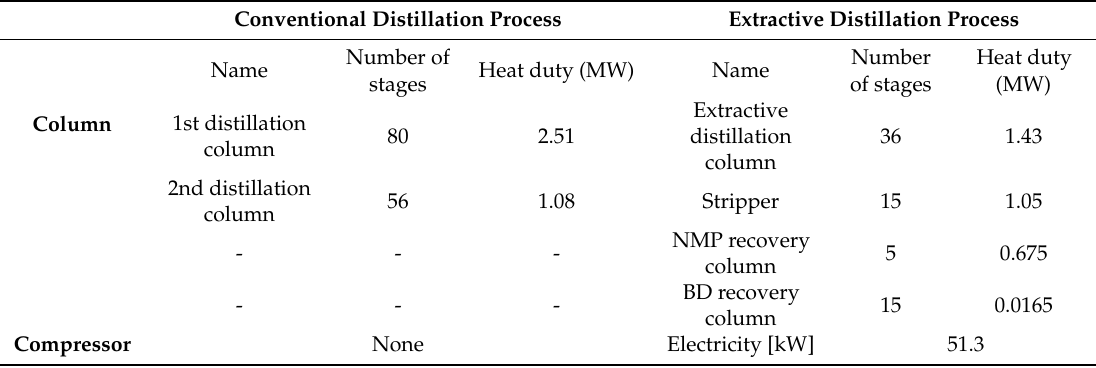
Table 1. Summary of number of columns, number of stages, heat duty, and compressor electricity that are required for the processes tested herein.